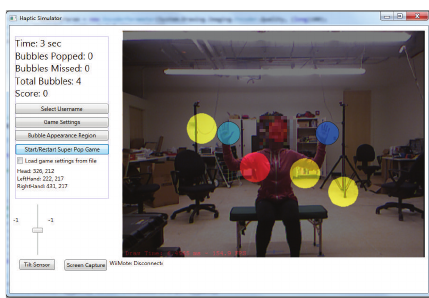
Figure 1: Super Pop VR game. The player needs to pop the yellow bubbles but to avoid the red bubble. The two blue bubbles represent the player’s hands. Please note that the locations, sizes, shapes, appearing time, and retaining time of the bubbles can be